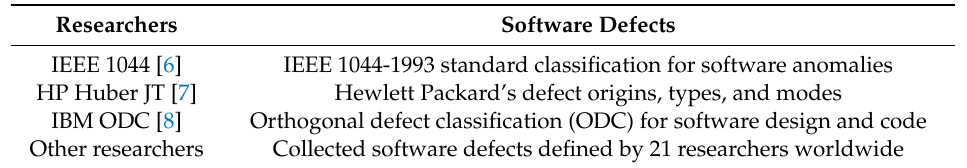
Table 1. Huh and Kim’s [5] references for pure software defects.